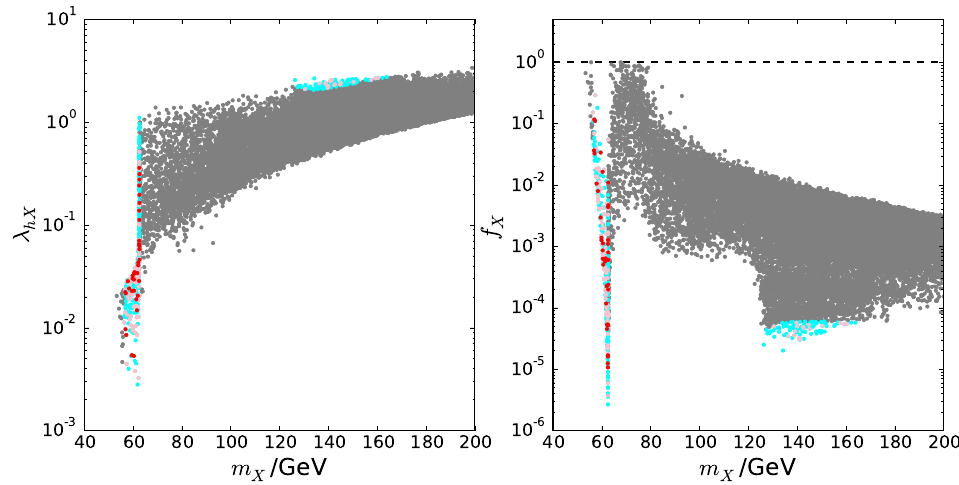
Figure 2 . The projected parameter space in the m X - (cid:21) hX plane (left) and in the m X - f X plane (right). The cyan, pink, red, and blue points are those satisfying the strongly (cid:12)rst-order PT conditions and the DM constraints, while the gray points are excluded by the DM direct detection experiment XENON1T. The cyan points are excluded by the conditions L w T c > 3 and (cid:11) < 0, while the pink points by the cuto(cid:11) scale conditions (cid:3) > 500 GeV and w 2 all the constraints.